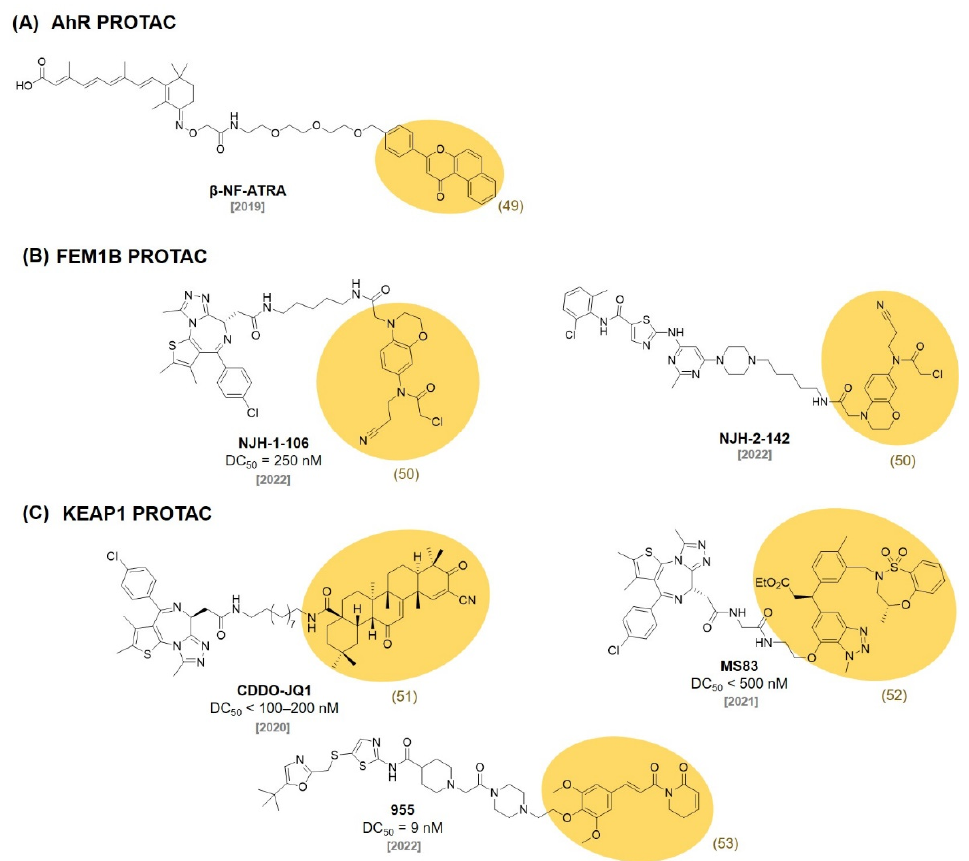
Figure 17. Chemical structures of PROTACs using ( A ) an AhR ligand, ( B ) FEM1B ligands, and ( C ) KEAP1 ligands.